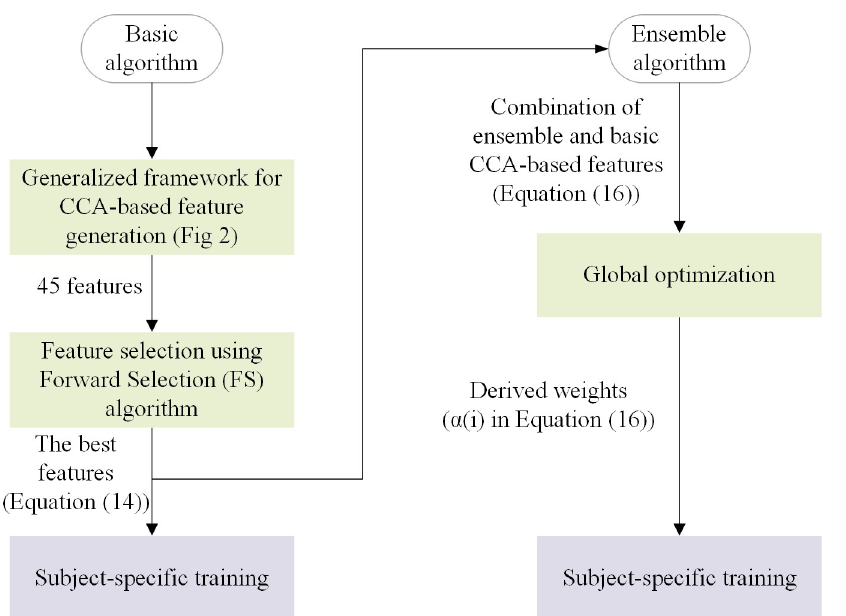
Fig 1. Structure of the proposed method and its ensemble version. Green and purple backgrounds represent subject-independent and subject-specific training, respectively.